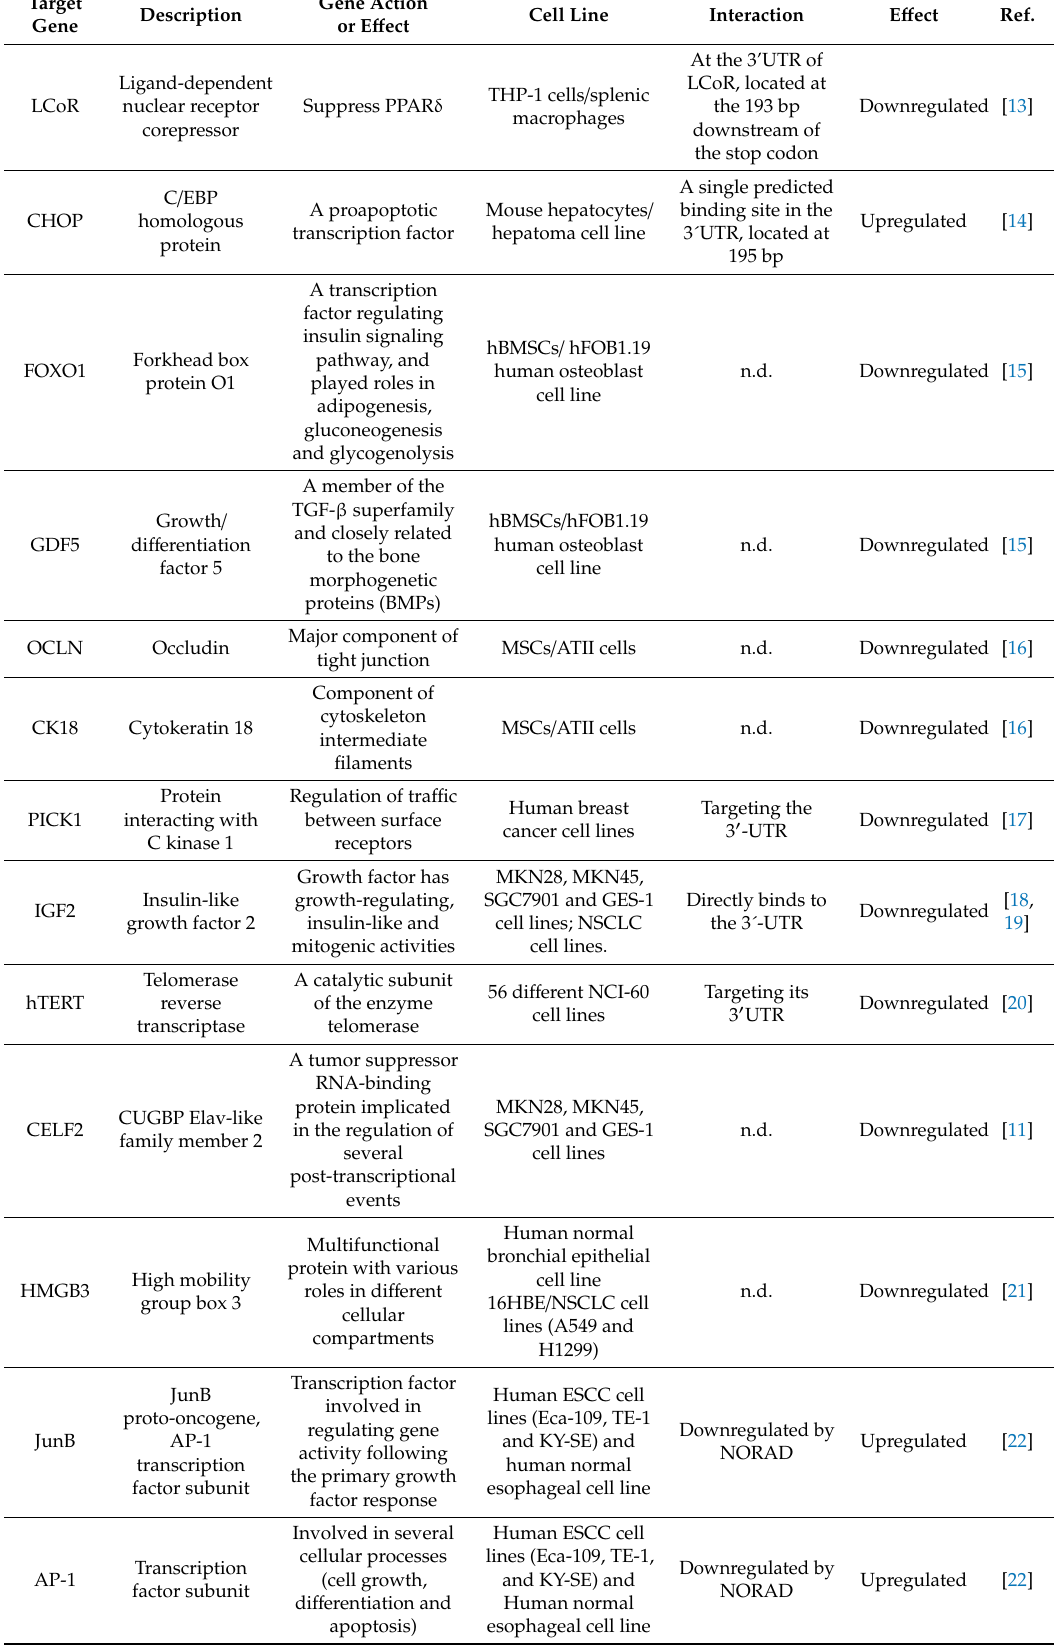
Table 1. miR-615-3p interacting